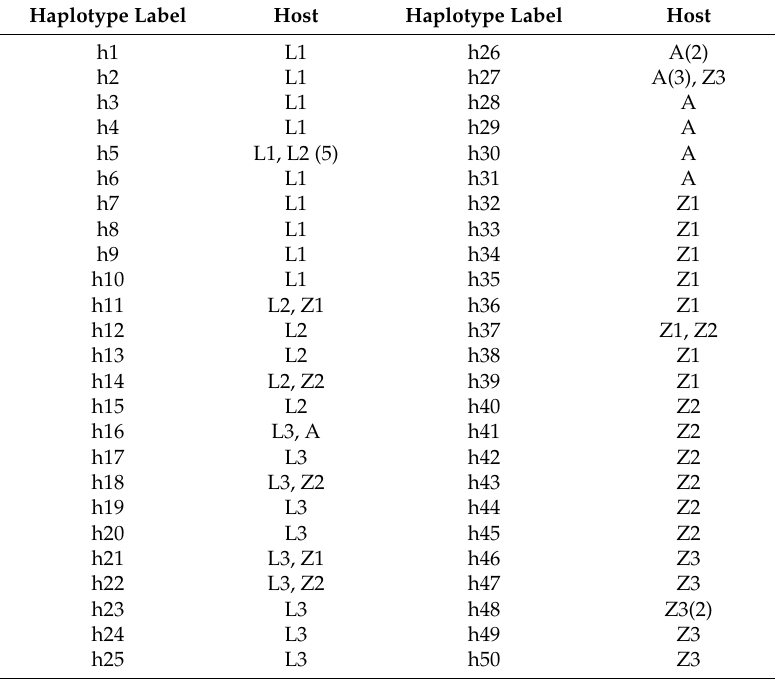
Table 2. List of the haplotypes identified in the “population genetics” approach, with respective label, host and frequency within the insect gut.